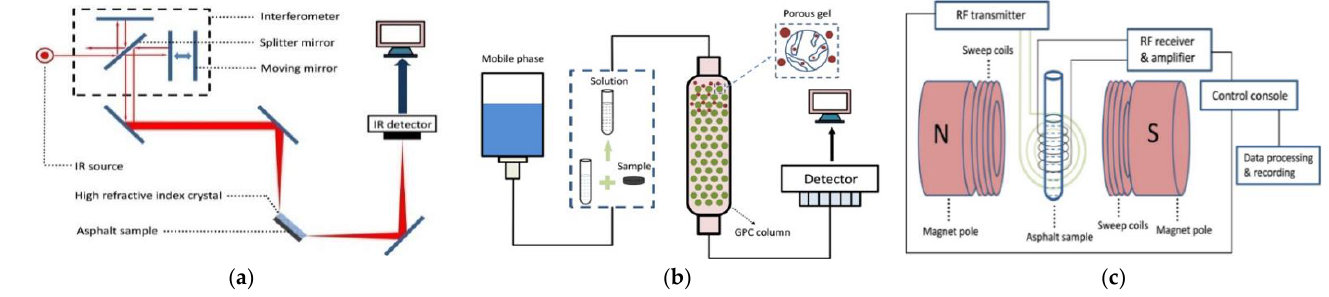
Figure 1. Schematic diagrams of three common chemical detection instruments: ( a ) FTIR, ( b ) GPC, ( c ) NMR.